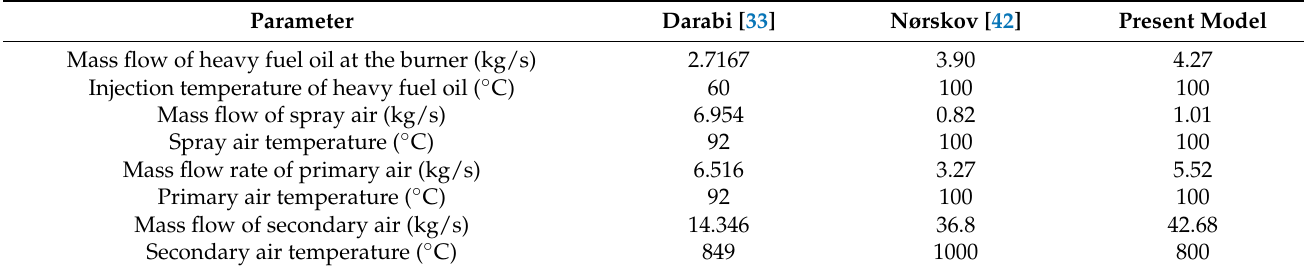
Table 6. Main operating characteristics of the burner.